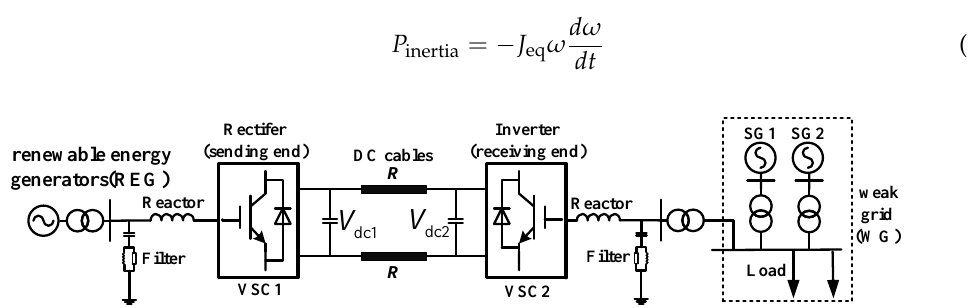
Figure 1. Single-line diagram of voltage source converter high voltage direct current (VSC-HVDC) transmission system.